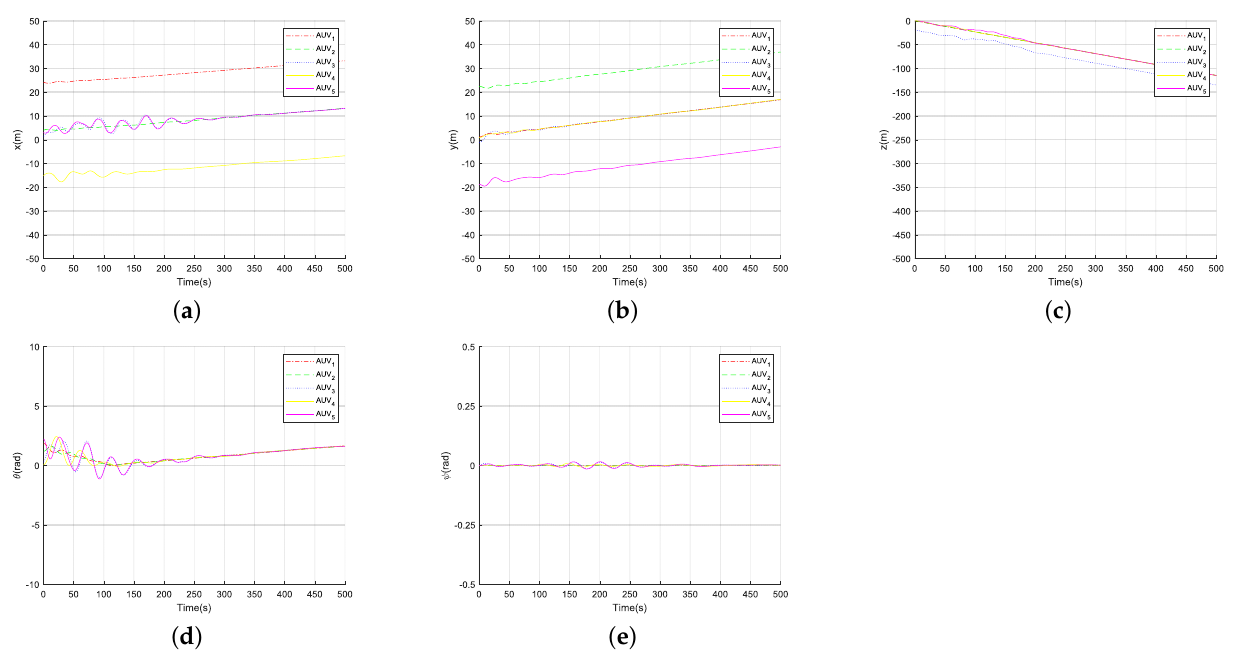
Figure 9. The position state of the multi − AUV formation: ( a ) the x state of multi − AUV, ( b ) the y state of multi − AUV, ( c ) the z state of multi − AUV, ( d ) the θ state of multi − AUV, ( e ) the ψ state of multi − AUV.